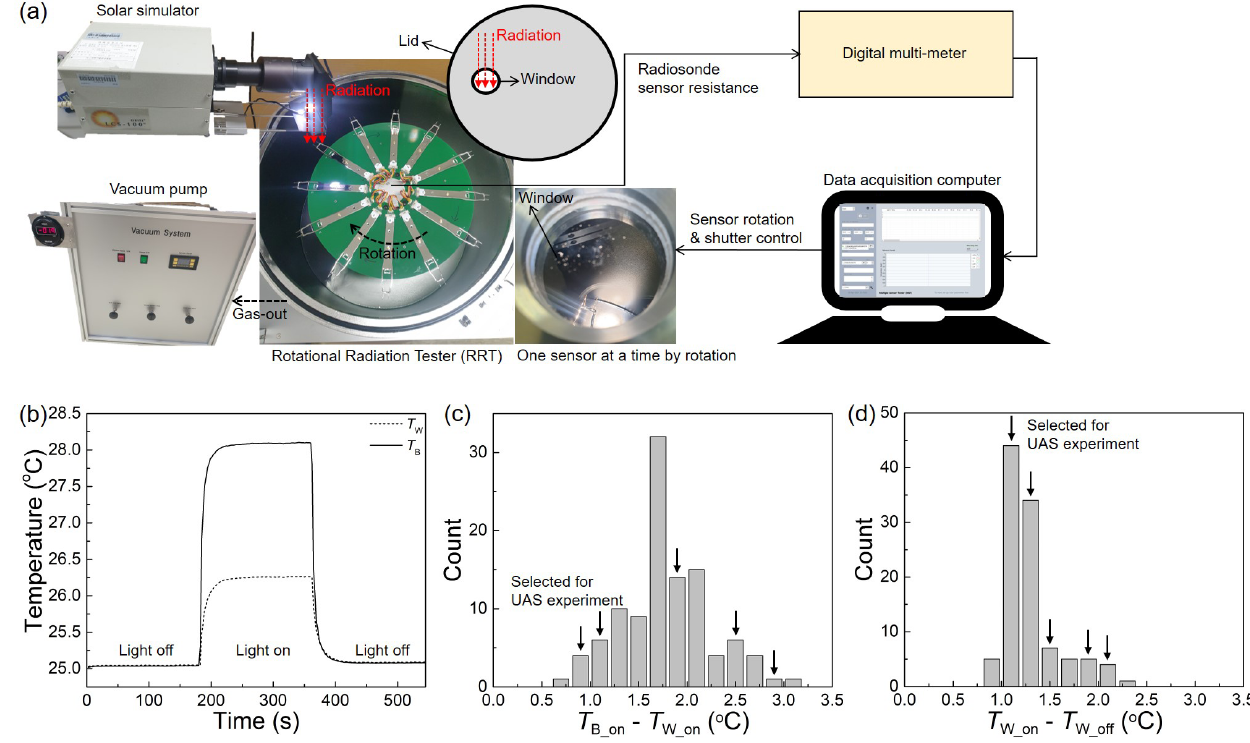
Figure 5. Rotational radiation test (RRT) on radiosonde thermistors individually. (a) RRT setup showing the radiosonde thermistors in a chamber, solar simulator, and vacuum pump (left), a digital multimeter (top right) and a data acquisition computer (bottom right). (b) Tem- perature measured by a white ( T W ) and black ( T B ) sensor with/without light irradiation by the solar simulator. (c) Distribution of the temperature difference between the paired white and black sensors. (d) Distribution of the temperature increase of white sensors by the irradiation. Five pairs of a white and black sensors were selected for radiation correction experiments using an upper air simulator (UAS), as indicated by black arrows in (c) and (d) .